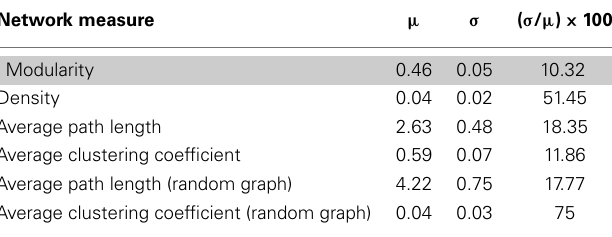
Table 1 | Four network measures calculated during the interictal stage: mean value ( µ ), standard deviation ( σ ) and percentage of relative standard deviation [( µ / σ ) × 100] during 1h of interictal stage